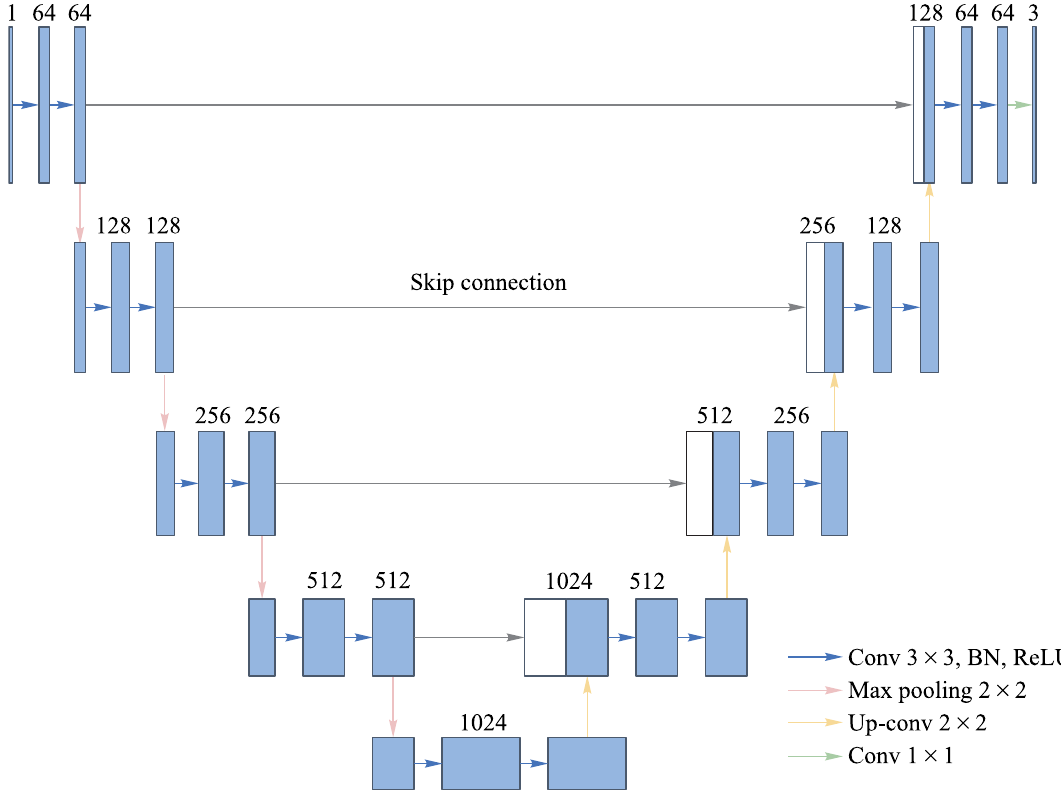
Fig. 2 Architecture diagram of the